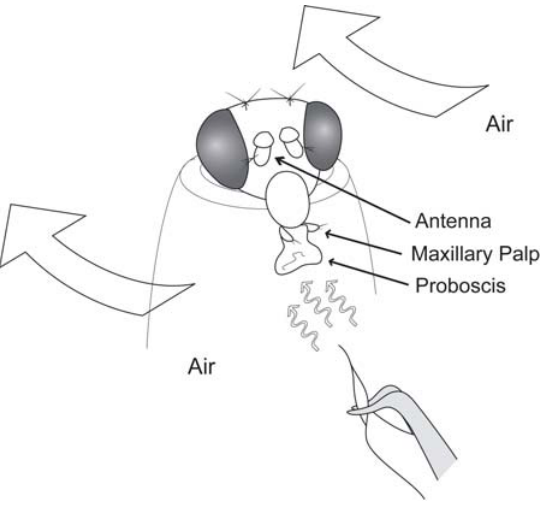
Figure 1. Fly immobilized for modified PER assay. The fly is placed into a truncated yellow tip. Tastant is presented to the fly with a